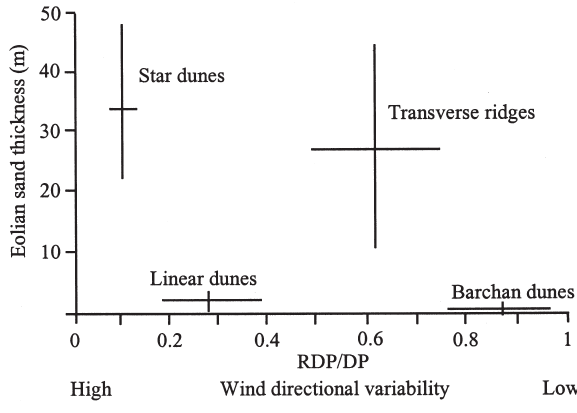
F IG . 1. – Equivalent sand thickness versus wind directional vari- ability to four elemental dune kinds (After Wasson and Hyde,